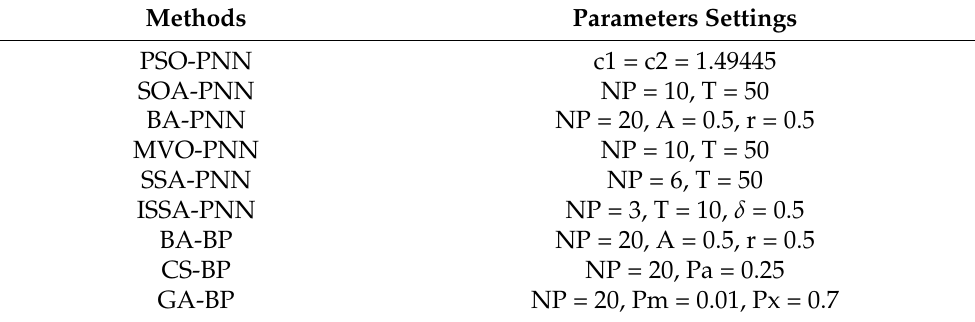
Table 4. Parameter setting of various methods.